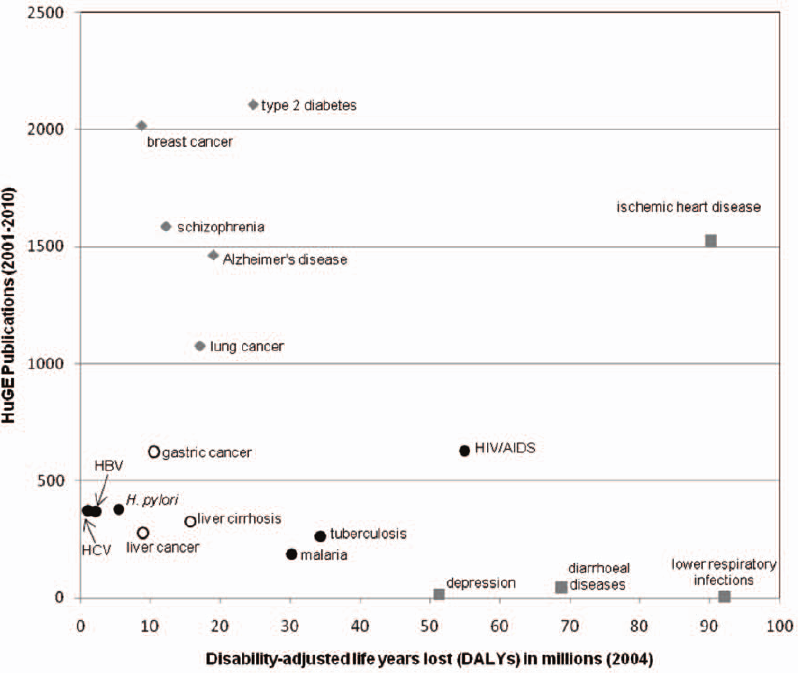
Figure 4. Selected infectious and chronic diseases according to worldwide morbidity (disability-adjusted life-years, DALYs) and publication frequency in human genome epidemiology (HuGE), 2001–2010. Solid black circles represent the six most frequently studied infectious diseases; open black circles represent three chronic diseases that are often part of the natural course of infection with HBV, HCV, or H. Pylori . Gray diamonds represent the four most frequently studied diseases overall. Gray squares represent the four diseases with the greatest morbidity worldwide; the fifth is HIV/AIDS, represented with a blue dot. ›